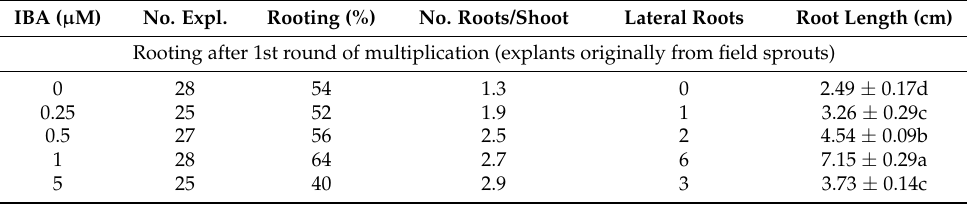
Table 3. Effect of IBA concentration on rooting of axillary shoots produced in vitro after one and two rounds of multiplication. Medium contained 1 / 2 MS